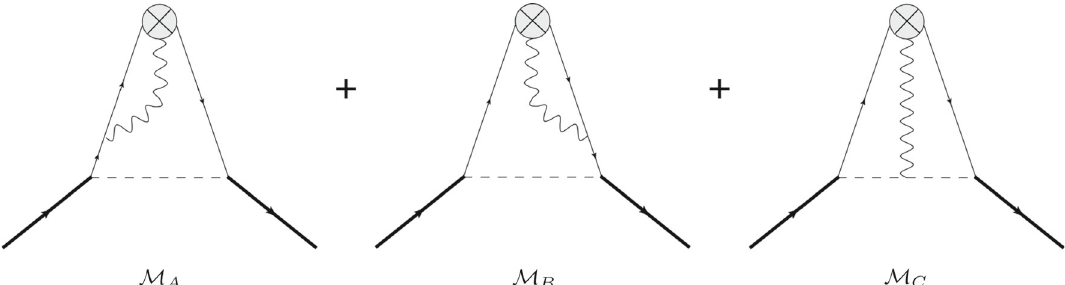
Fig. 2 Diagrams contributing to the quark potential TM and AM at O (λ 2 e q e s ) in perturbation theory. The dotted line represents the scalar diquark, the solid thin (thick) line represents the quark (nucleon), and the wavy line represents the photon. The crossed blob represents the insertion of an external operator